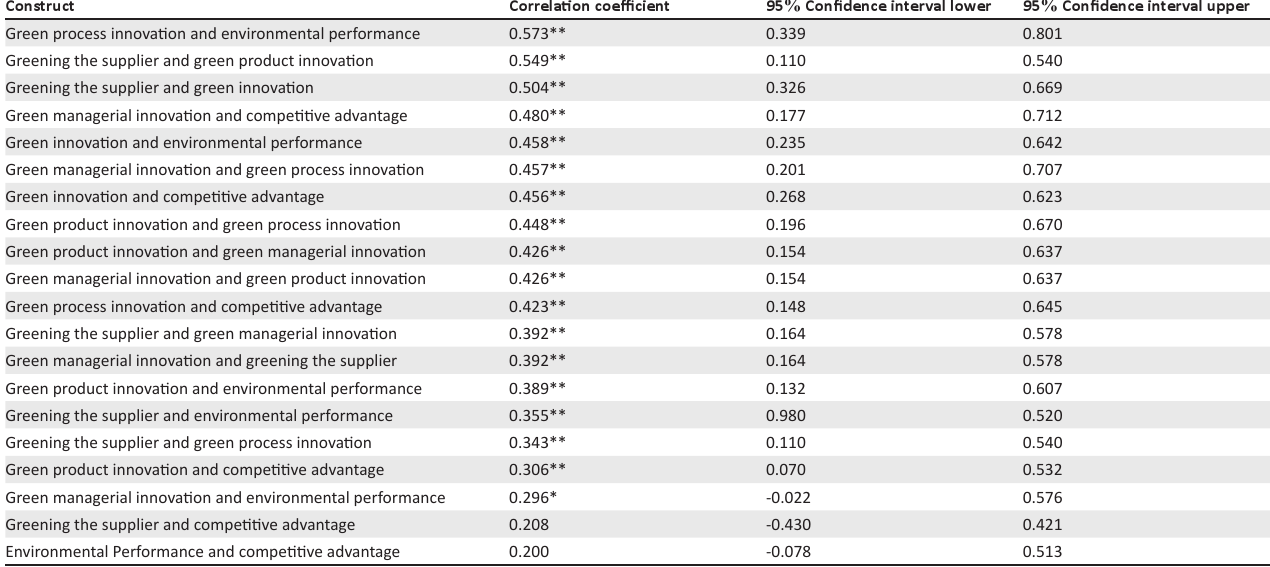
TABLE 3: Kendall’s tau b coefficients between latent constructs.